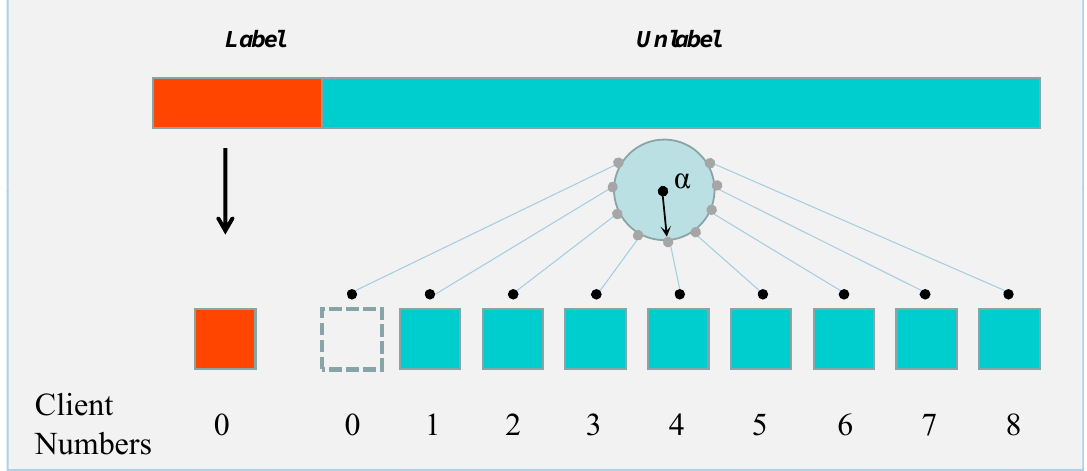
Figure 3. Controlled label-free data distribution method.